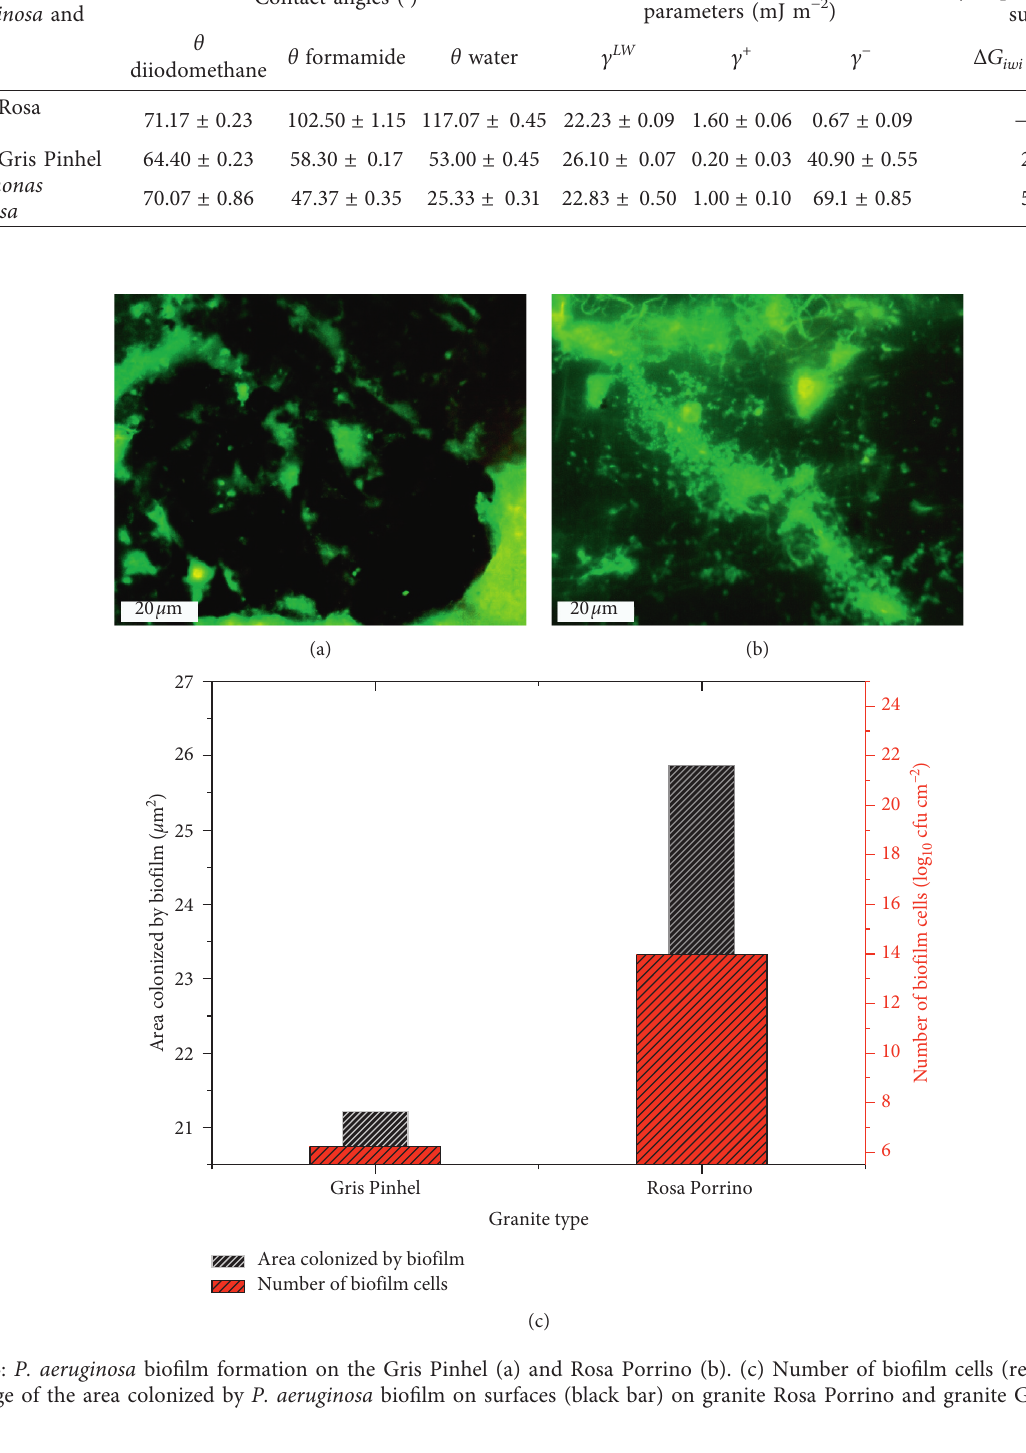
Table 2: Contact angles, surface tension parameters (Lifshitz-van der Waals component ( c LW ) ; electron acceptor ( c + ) , electron donor component ( c − ) ), and hydrophobicity ( Δ G iwi ). The means ± SD for three replicates are given. P. aeruginosa and